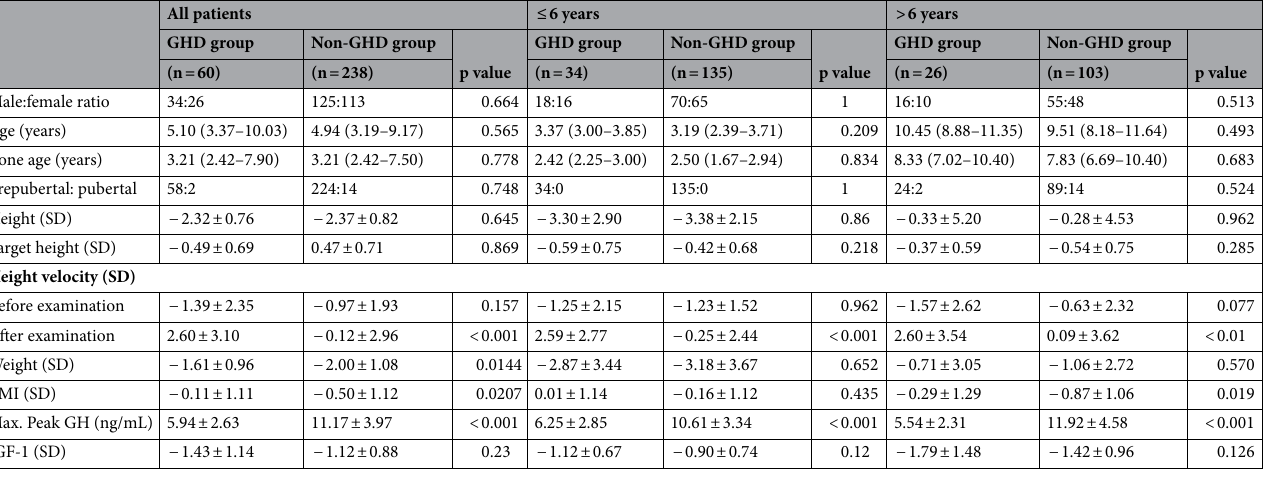
Table 1. Patient characteristics. The values are expressed as medians (IQR) or means ± SD. SD, standard deviation; BMI, body mass index; GH, growth hormone; GHD, growth hormone deficiency; IGF-1, insulin- like growth factor; IQR, interquartile